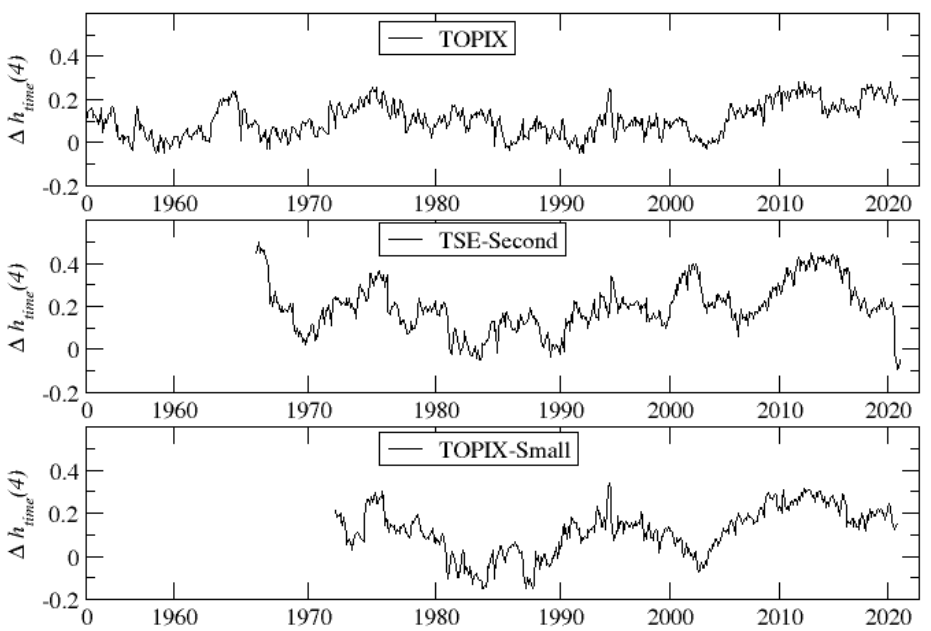
Figure 7. Time evolution of the time-correlation component of the degree of multifractality, ∆ h time ( 4 )